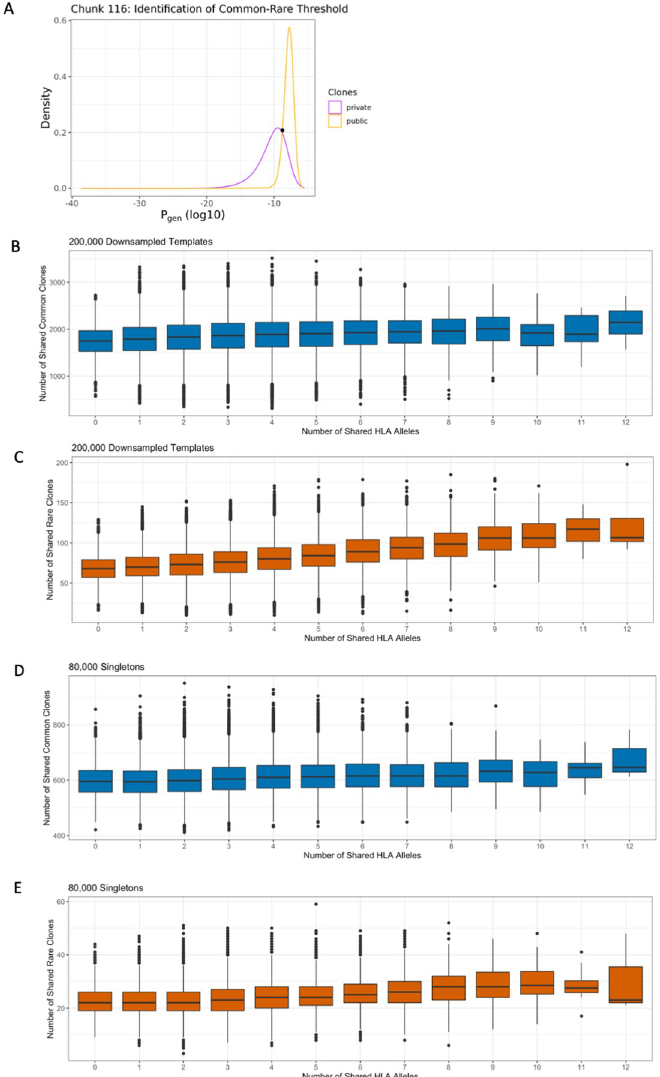
Fig 3. TCR β clone sharing among common and rare clones. Clones were classified as common versus rare by identifying a generation probability cutoff point between clones occurring once and those occurring more than once in 31 different “chunks” representing the entirety of TCR β rearrangements observed in the down-sampled data. (A) Intersection point from a single representative “chunk.” The number of shared HLA alleles was significantly correlated with clone sharing among both (B) common (Mantel rho = 0.12, p < 1e-3) and (C) rare clones (Mantel rho = 0.28, p < 1e-3). Similarly, the number of shared HLA alleles was significantly correlated with sharing of singletons among (D) common (Mantel rho = 0.14, p < 1e-3) and (E) rare (Mantel rho = 0.18, p < 1e-3)